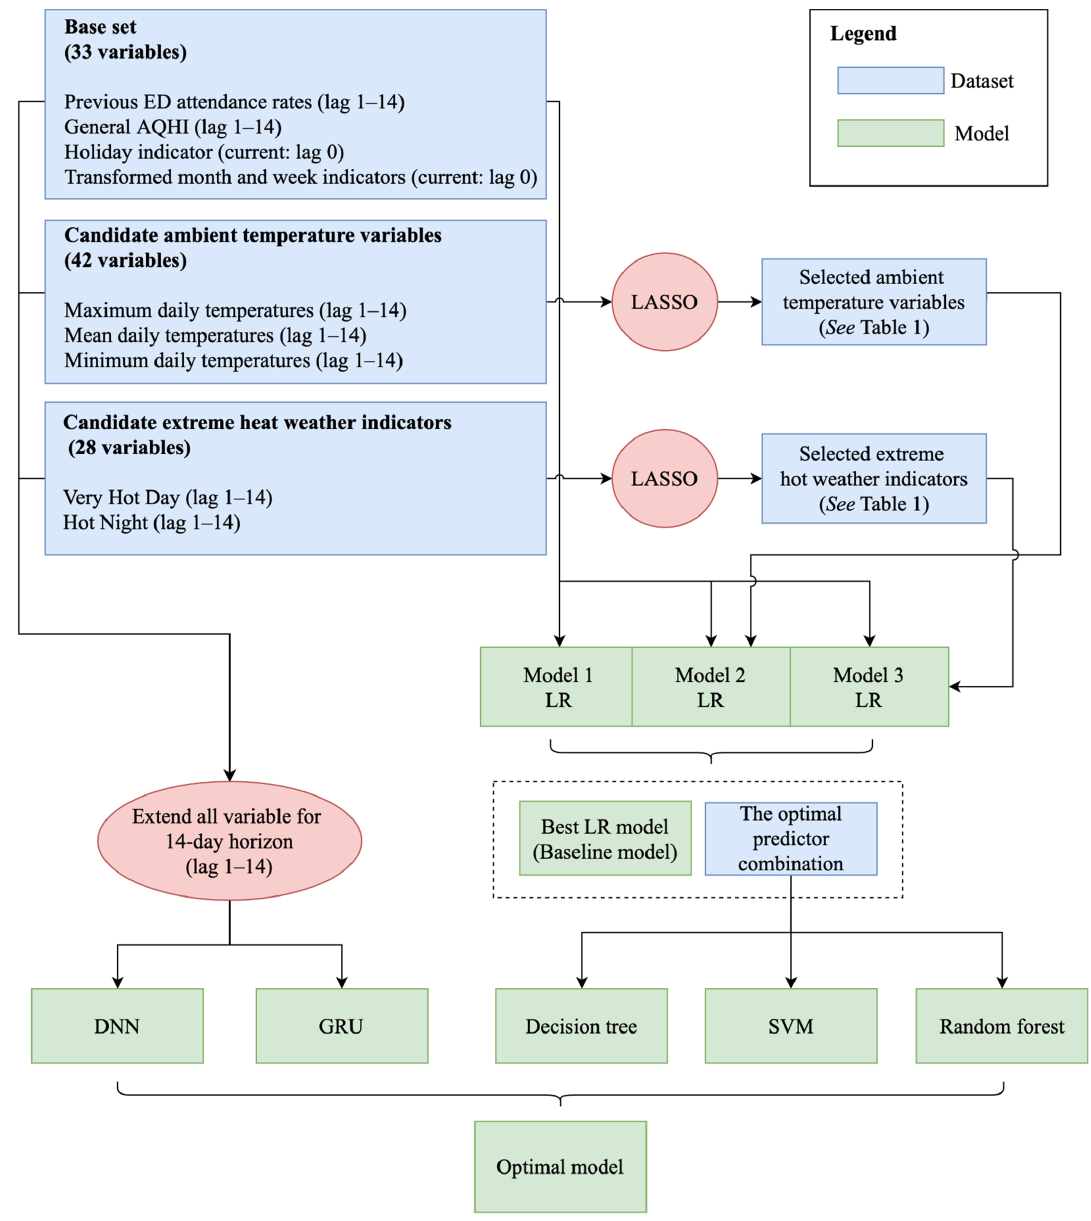
Figure 1. Process of the statistical analysis. Note: LASSO denotes least absolute shrinkage and selection operator, LR denotes linear regression, SVM denotes support vector machine, DNN denotes deep neural network, and GRU denotes gated recurrent unit.